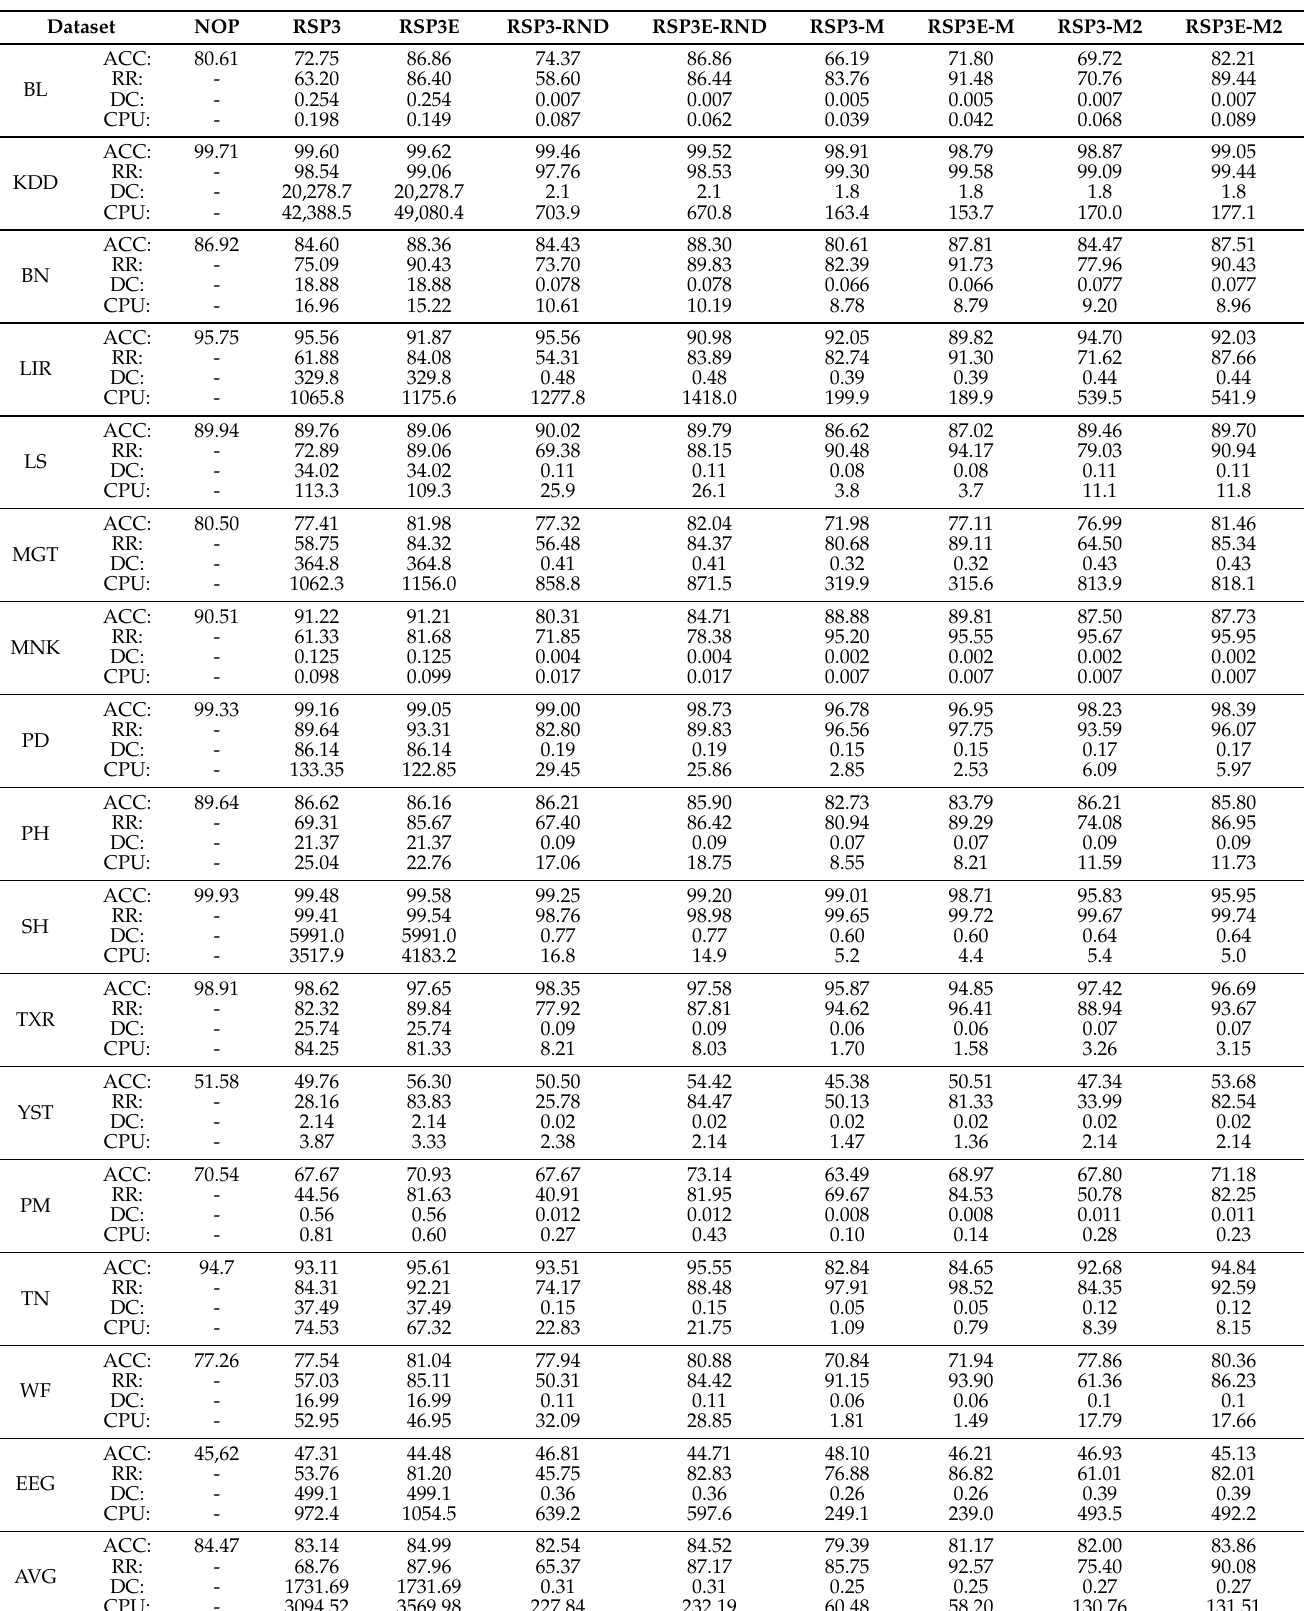
Table 2. Comparison in terms of ACC(%)), RR(%), DC(M) and CPU